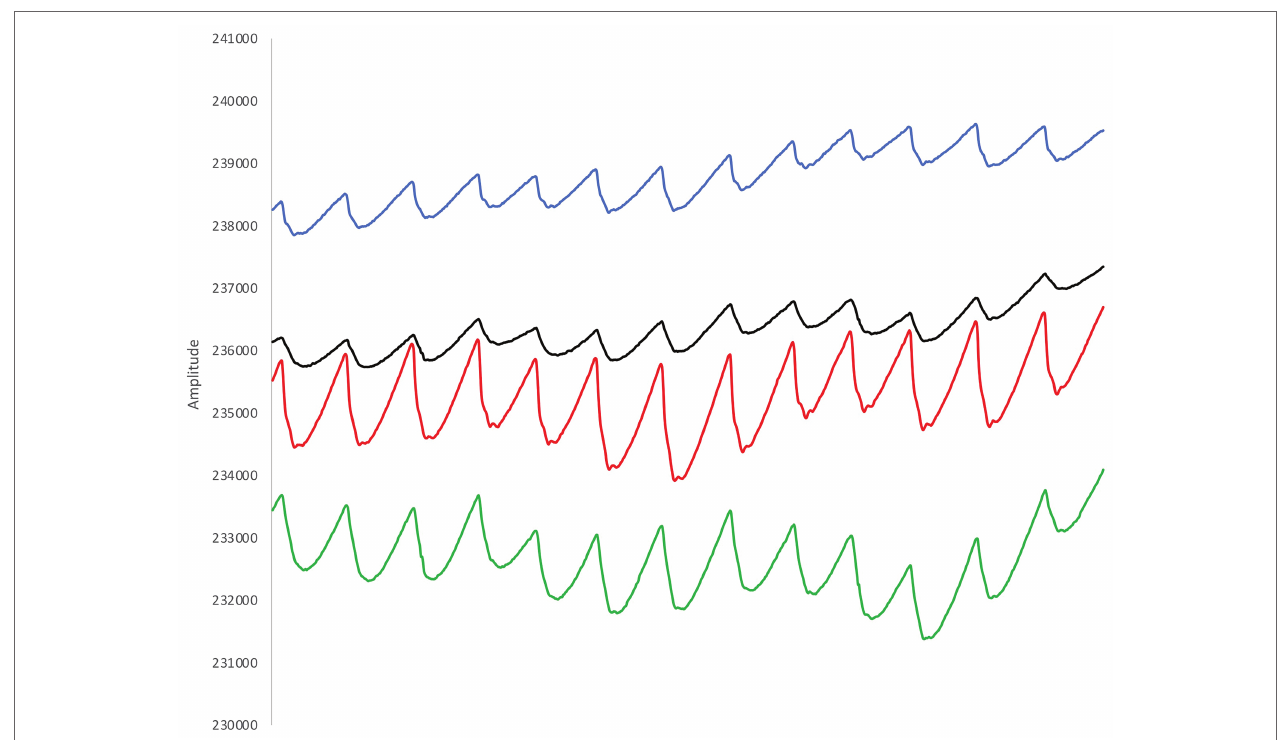
FIGURE 3 | Example from the recorded plethysmograms (two signals for red light and two signals for infra-red light). The pulsatile signals show a large waveform with a sharp peak and a clear dicrotic notch, indicating good signal